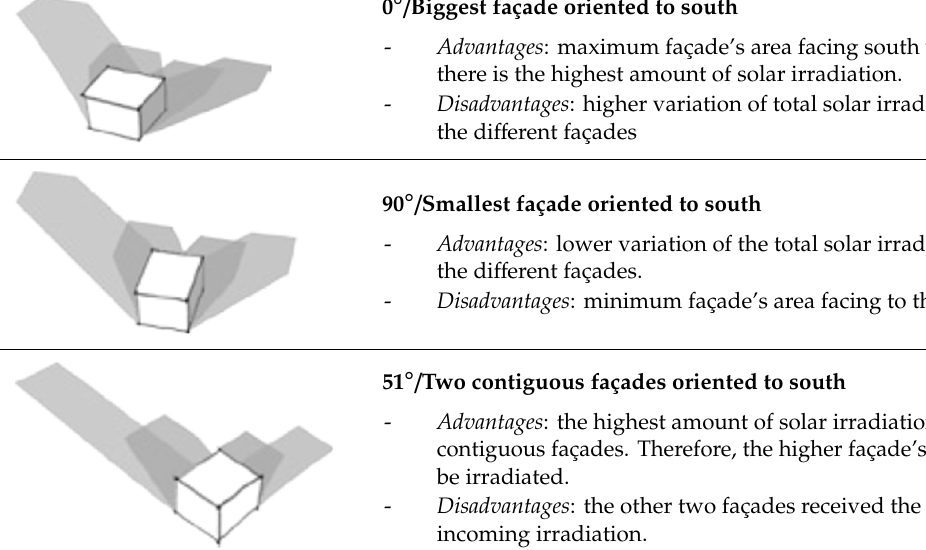
Table 9. Advantages and disadvantages of optimization performed by the Galapagos evolutionary solver on solar analyses in Step 2 .